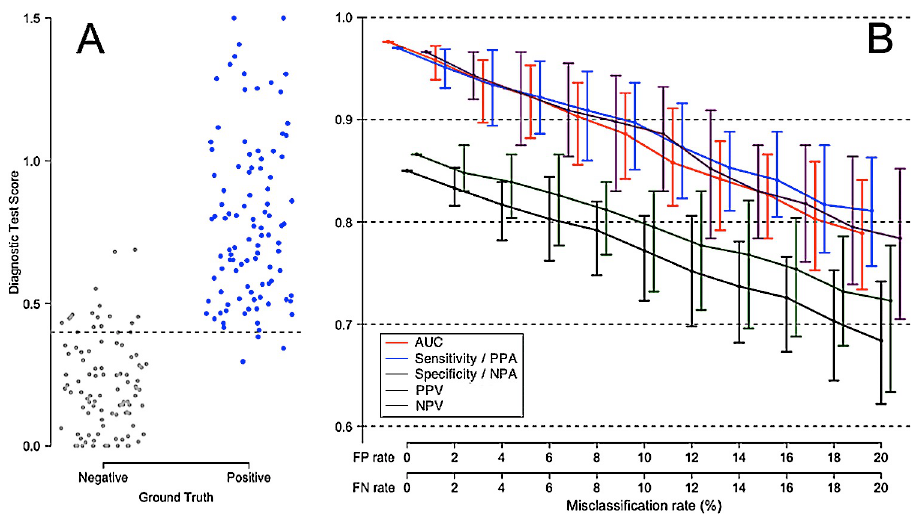
Fig 4. Degradation of apparent performance of a perfect diagnostic test, as a function of error in the comparator. (A) Representation of Ground Truth for 100 negative patients (grey points) and 100 positive patients (blue points). A slight overlap between Ground Truth negative and Ground Truth positive distributions is assumed, leading to AUC 0.98 with the Ground Truth as reference. (B) Apparent performance of a perfect diagnostic test, as a function of the misclassification rate of the comparator. The error bars describe 95% empirical confidence intervals about medians, computed over 100 simulation cycles. True test performance is indicated when the FP and FN rates are each 0%. The terms Sensitivity and Specificity are appropriate when there is no misclassification in the comparator (FP rate = FN rate = 0%). The terms Positive Percent Agreement (PPA) and Negative Percent Agreement (NPA) should be used in place of Sensitivity and Specificity, respectively, when the comparator is known to contain